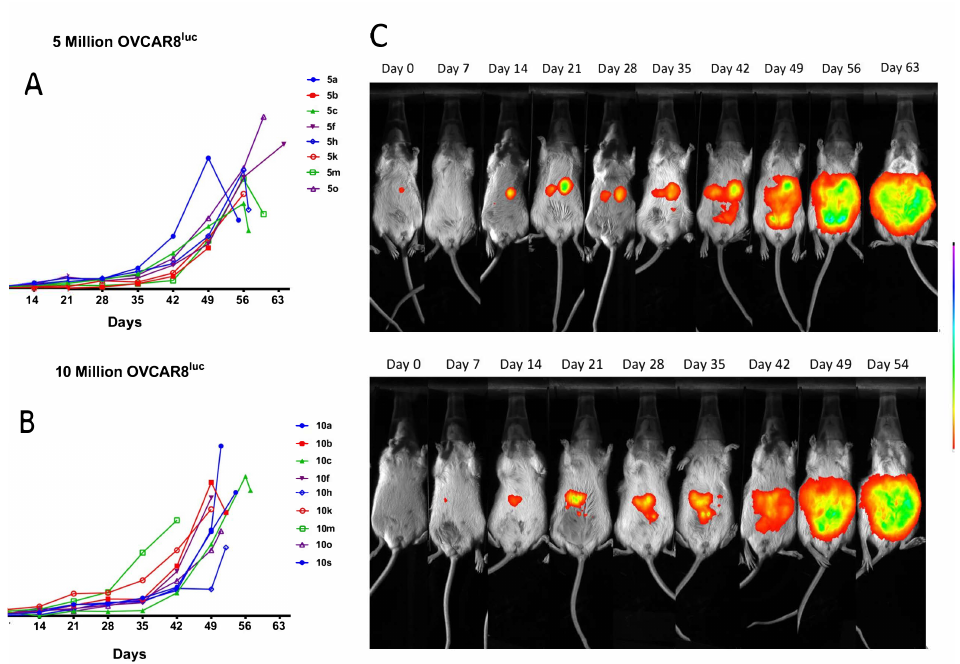
Figure 1. Quantification of bioluminescent signal in mice inoculated with ( A ) 5 million and ( B ) 10 million OVCAR8 luc cells. Bioluminescent imaging (BLI) was performed as described in methods; each line represents a single mouse. ( C ) The representative figures show successive images of the same animal in each group, top: 5 million group; bottom: 10 million group. Color scale bar indicates photon / s / mm 2 of the camera field.